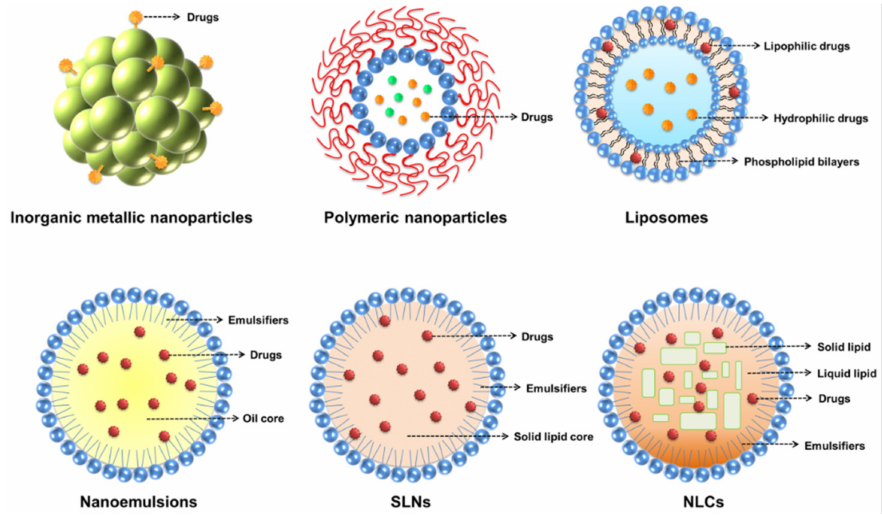
Figure 4. The different types of nanoparticles for inhibiting